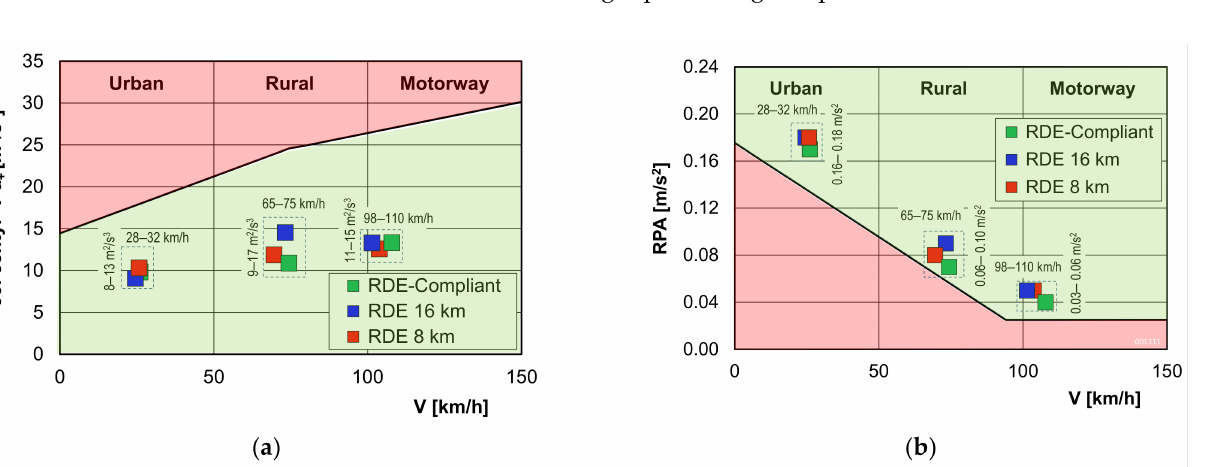
Figure 3. Dynamic conditions (mean values) in each test: RDE-Compliant, RDE 16 km and RDE 8 km: ( a ) 95th percentile of the product of velocity and positive acceleration; ( b ) relative positive acceleration. Dashed lines indicate the range of variation in speed and dynamic indices for all test repetitions